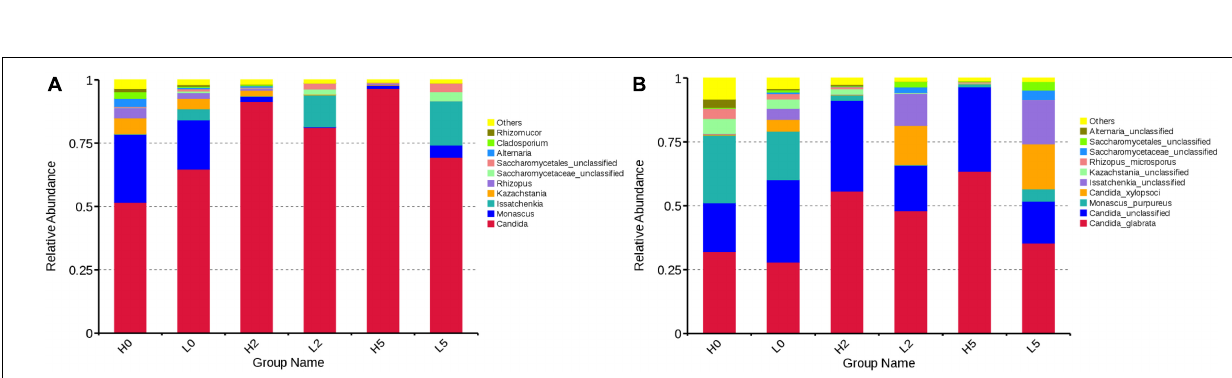
FIGURE 4 | Relative abundance of fungal communities in whole-plant corn silage (A) , at the genera level; (B) , at the species level. H, ensiled whole corn plants with a high moisture content (680 g/kg) harvested at the one-third milk-line stage; L, ensiled whole corn plants with a low moisture content (620 g/kg) harvested at the two-thirds milk-line